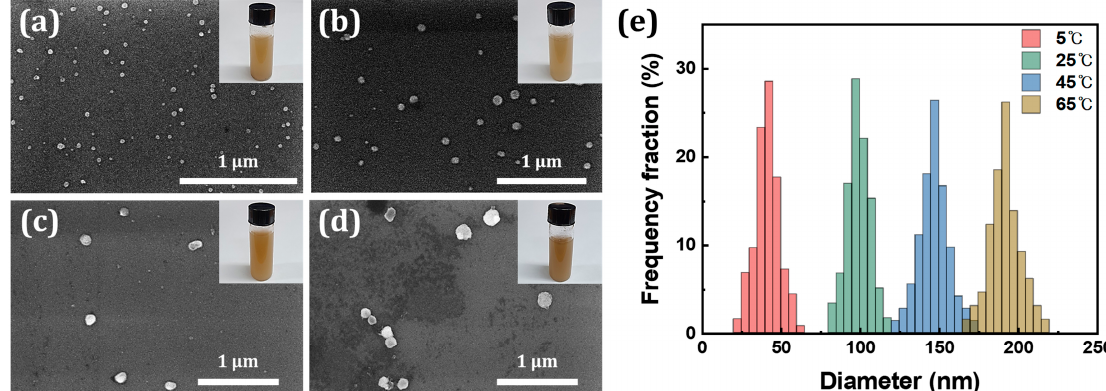
Figure 5. FESEM images of NPs synthesized at temperatures of ( a ) 5 °C, ( b ) 25 °C, ( c ) 45 °C, and ( d ) 65 °C at a constant voltage of 7.5 V (insets: digital photographs of synthesized SiO x NPs dispersed in DI water). ( e ) The size distributions of synthesized NPs.